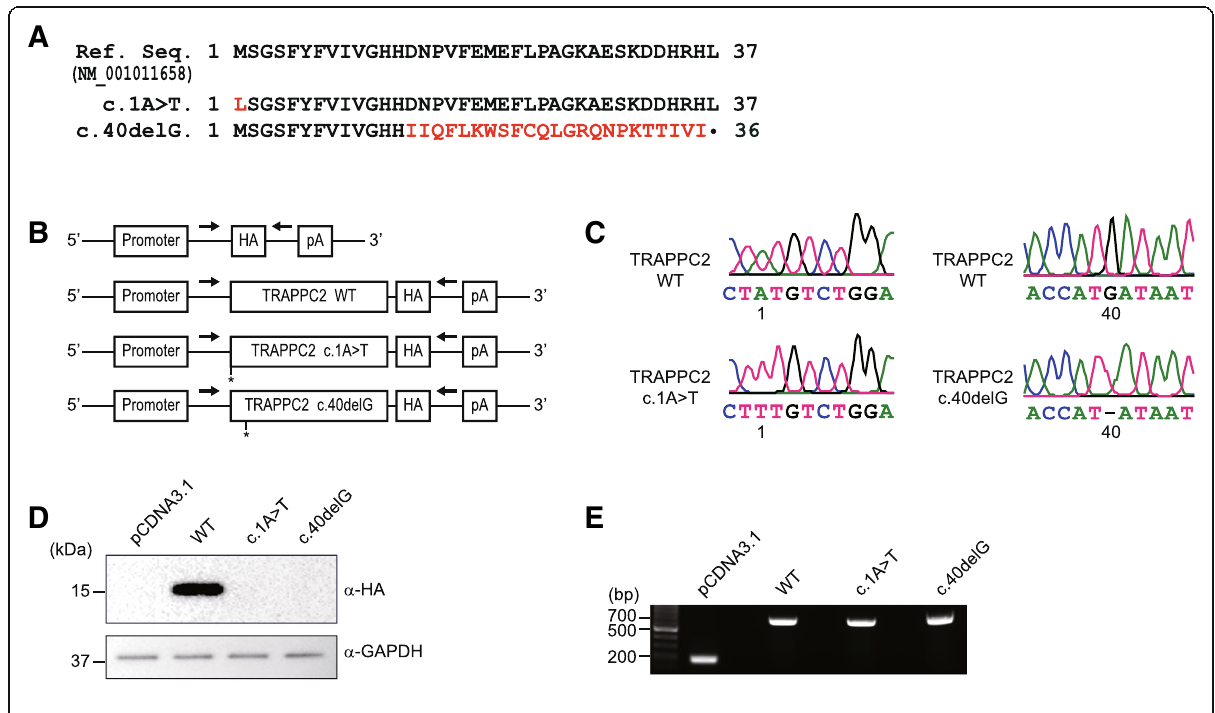
Fig. 2 Functional analysis of TRAPPC2 variants found in the SEDT-XL patients ( a ) Predicted amino acid sequences of the TRAPPC2 variants found in the SEDT-XL individuals. The c.1A > T missense variant would change the starting codon Methionine to Leucine. The deletion variant, c.40delG, would only produce the first 13 amino acids correctly and then abruptly terminate the translation. The gene accession number for human TRAPPC2 mRNA is indicated. b DNA constructs used in this study. Wild-type (WT) or the TRAPPC2 variants are expressed under the CMV promoter. HA tag is introduced at the C-terminus of the cDNAs and thus the HA tag does not affect translation of the TRAPPC2 variants. The arrows indicate primers for RT-PCR. These primers are specific to the vector used in this experiment to exclude any endogenous TRAPPC2 genes. c Chromatogram displaying the mutations in the TRAPPC2 expression vectors. A missense mutation at the position 1 showed a change of base from adenine to thymine in the left pair. A deletion of guanine at the position 40 is demonstrated in the right pair. d - e Analyses of the TRAPPC2 variant expression at protein and transcript level. 293T HEK cells were transfected with individual pCDNA3.1, WT, or TRAPPC2 variant expressing vector, and cell lysates were subjected to Western blot analysis with HA antibody ( d ) and used to prepare total RNA for RT-PCR ( e ). The size markers for DNA fragments and proteins are